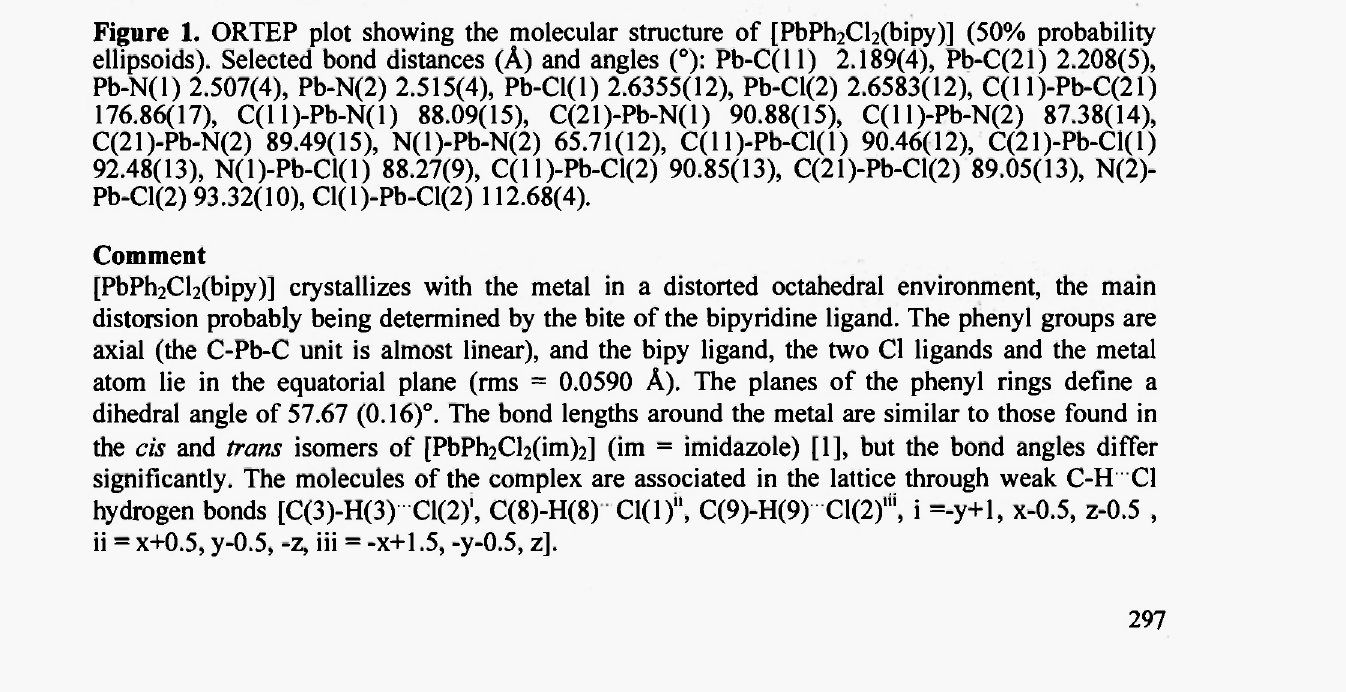
Cl (bipy)] (50% probability 2 2